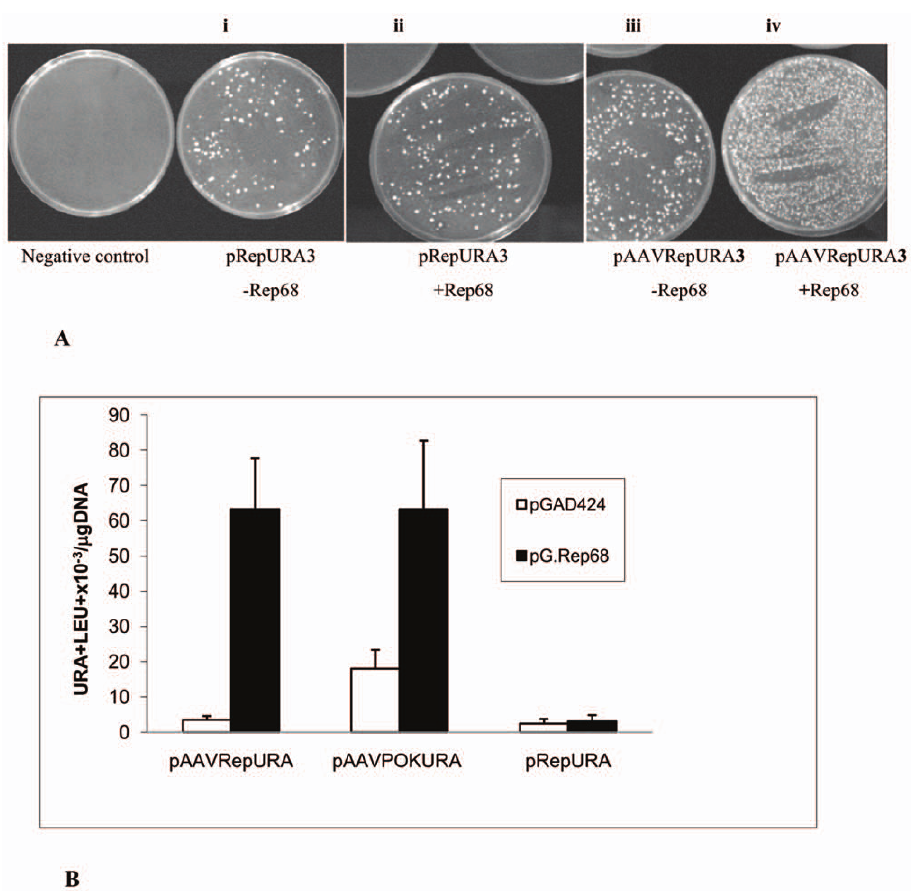
Figure 2. The frequency of colonies carrying the AAV genome increased when Rep68 is expressed. The plasmid pAAVRepURA3, pAAVpokURA linearized with Pvu II and the control plasmid, pRepURA3, digested with Xba I, were co-transformed with the plasmid pGAD424 or pG.Rep68 containing the LEU2 marker gene (A, B). (A) Representative plates comparing colonies obtained from the transformed yeast RSY12 strain with plasmid pRepURA and pGAD424 (i), pRepURA and pG.Rep68 (ii), pAAVRepURA and pGAD424 (iii); pAAVRepURA and pG.Rep68 (iv). (B) Transformed yeast cells were scored for their ability to form colonies on selective medium lacking leucine and uracil. The frequency was calculated as described in material and methods. Results are the mean of 4 independent experiments 6 standard deviation.